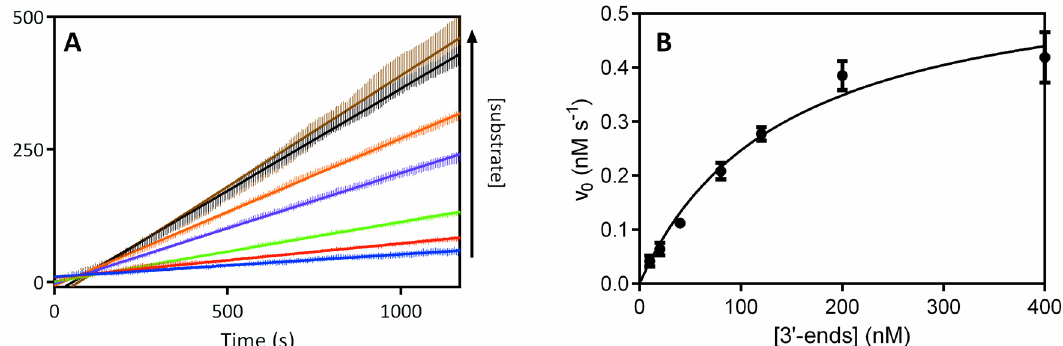
Fig 2. Exonuclease III steady state kinetics with increasing concentration of substrate by phosphate release assay. 1.5 nM ExoIII was incubated with 1 μ M MDCC-PBP, 0.0004u/ μ l FastAP and varying concentrations (5, 10, 20, 40, 60, 100 and 200 nM) of dsDNA substrate in 66mM Tris-HCl (pH 8.0) and 0.66mM MgCl 2 at 37°C. (A) Fluorescence increase was measured over time from the ExoIII reaction coupled to FastAP dephosphorylation of products and subsequent P i binding to MDCC-PBP. Background measured in parallel of a reaction without enzyme was subtracted from each data set. Fluorescence increase was converted to [P i ] by interpolation from standard curve (S5 Fig). Data points are shown as bars of standard error of the mean of three independent experiments. Arrow ( " ) refers to the increasing concentration of substrate in the different data sets. (B) Michaelis-Menten saturation curve by plotting initial velocity (v 0 ) obtained from (A) against 3 ’ -end concentration. Constants derived from plot were V max = 0.5947 ± 0.0380 nM s -1 and K M = 140.9 ± 20.3 nM.